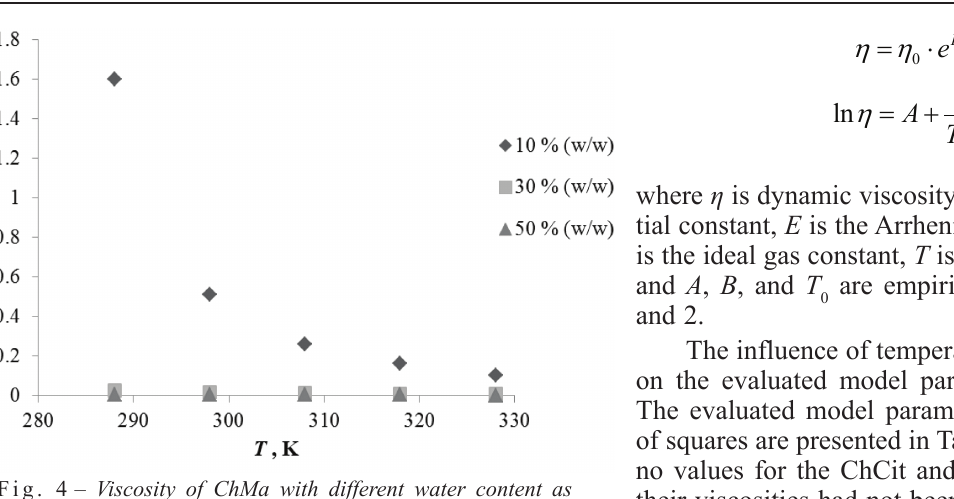
Fig. 4 – Viscosity of ChMa with different water content as function of